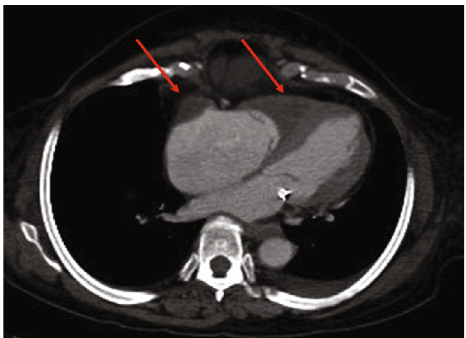
Figure 2: CTA showing evidence of right atrial and right ventricular apical thrombus (red